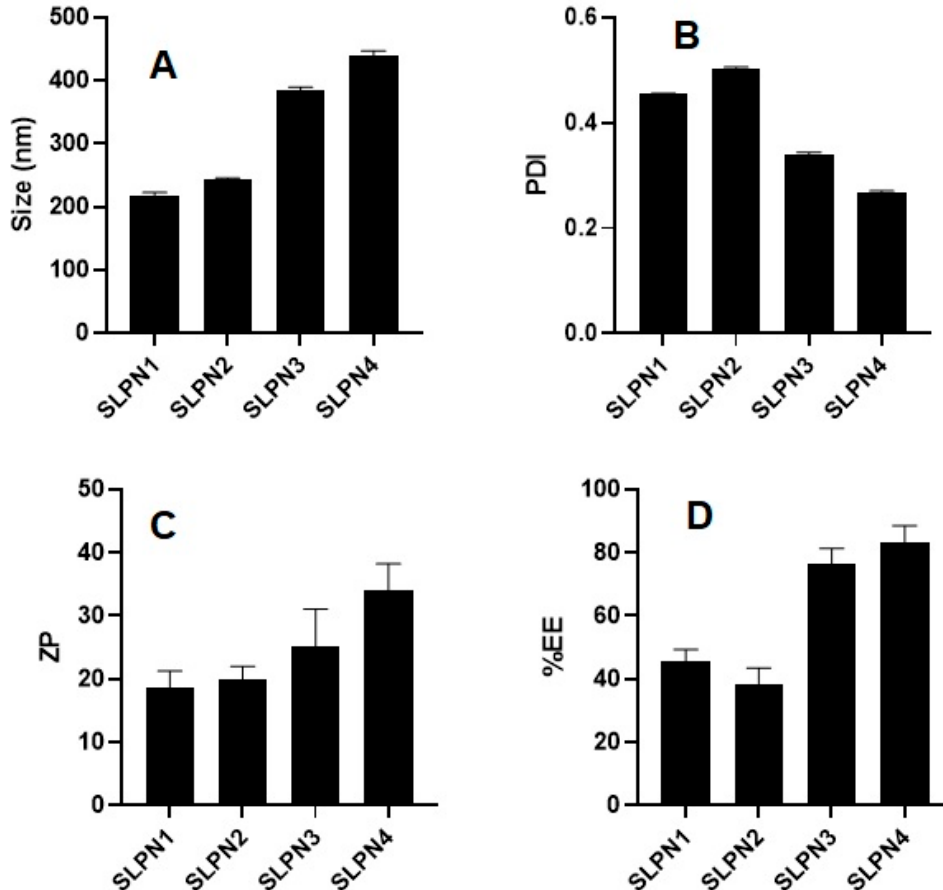
Figure 2. Particle size, PDI, ZP, and %EE of developed SM-loaded lipid polymer nanoparticles